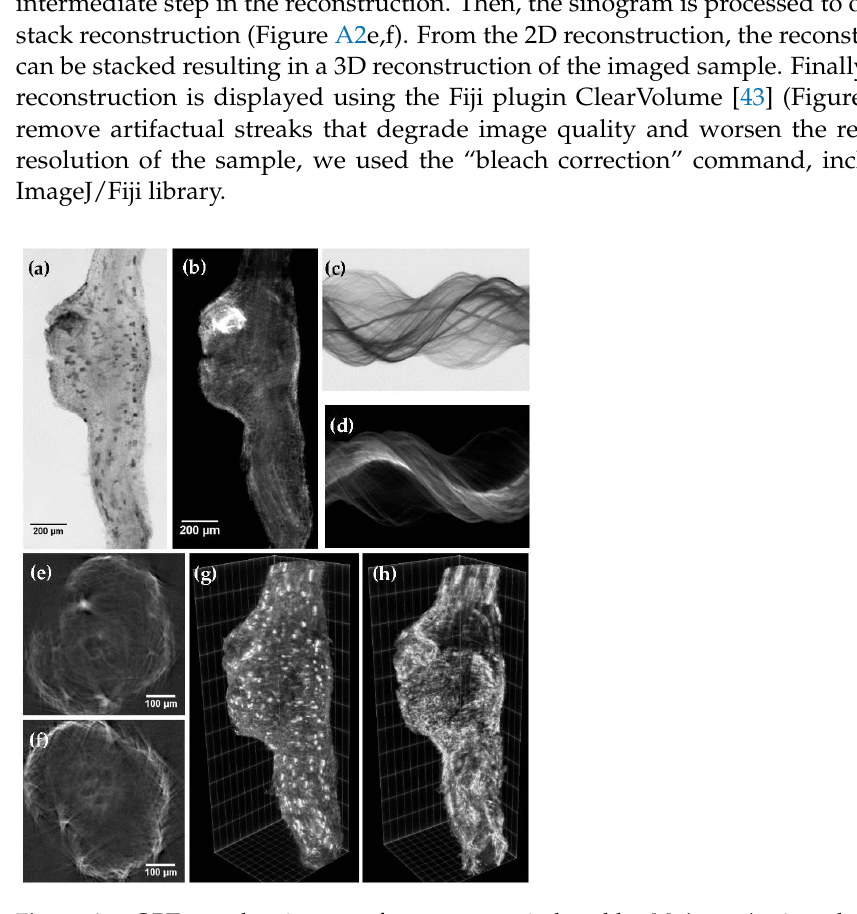
Figure A2. OPT raw data images of tomato roots induced by M. incognita 6 weeks after inoculation cleared with 1-propanol–ECi in ( a ) brightfield and ( b ) fluorescence mode. Scale bar: 200 µm. ( c ) Brightfield sinogram and ( d ) fluorescence sinogram. ( e ) Brightfield OPT stack reconstruction and ( f ) fluorescence OPT stack reconstruction, after back-projection algorithm. Scale bar: 100 µm. Three-dimensional reconstructions of roots in ( g ) brightfield and ( h ) fluorescence modes.